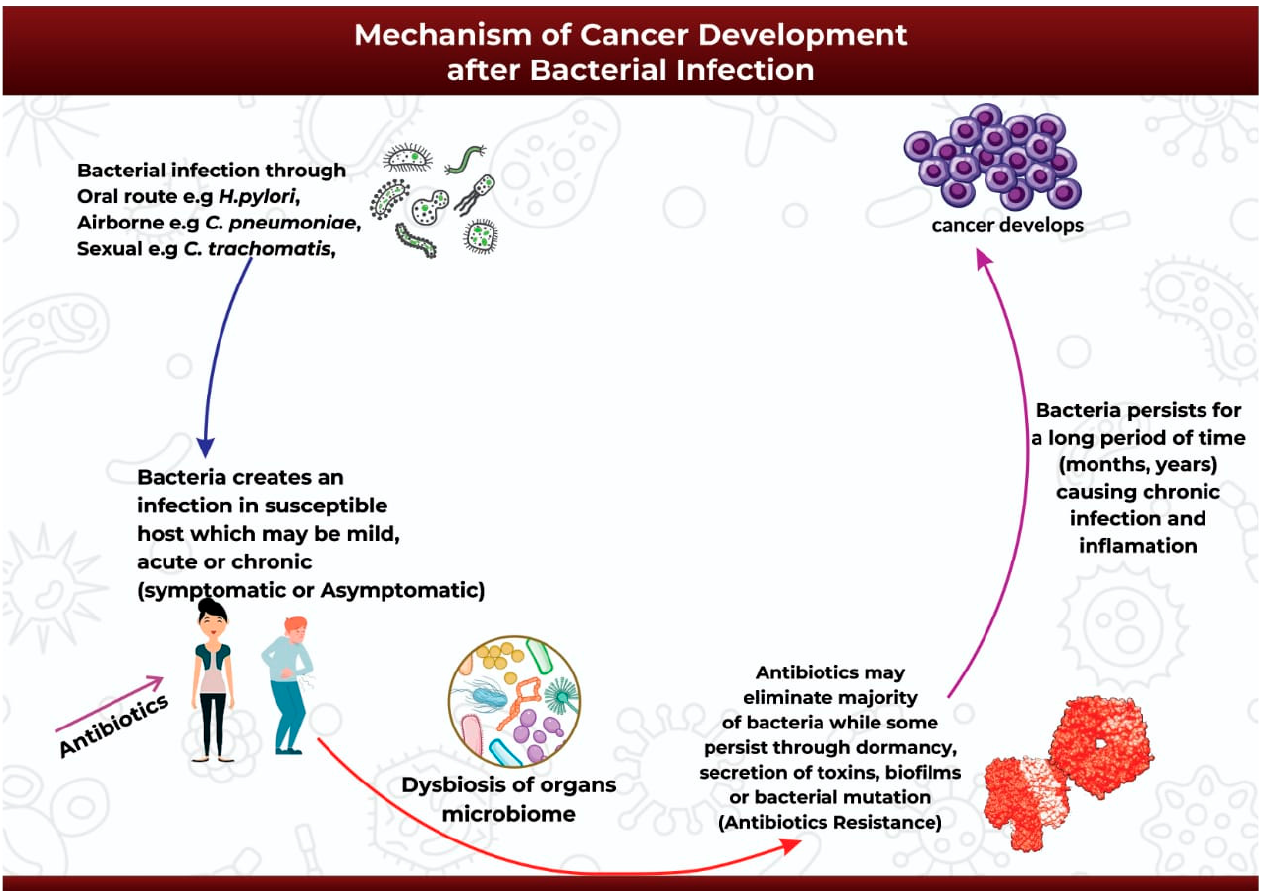
Figure 2. An illustration of the mechanism of cancer development after bacterial infection